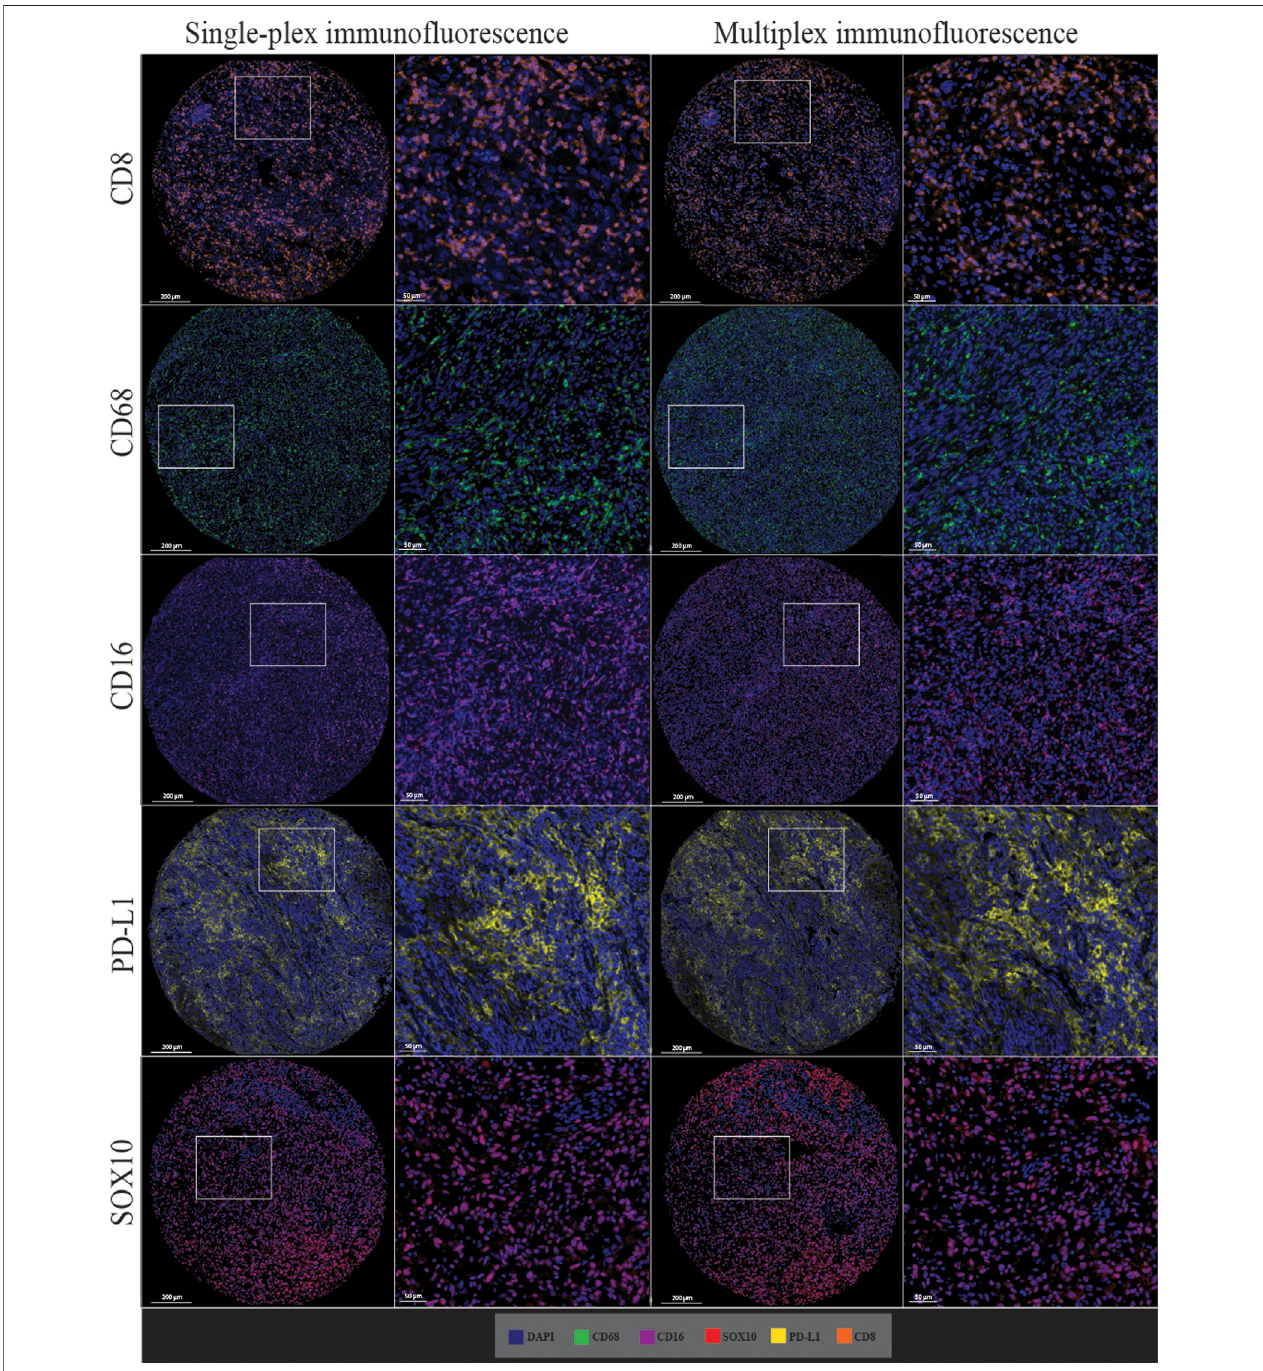
FIGURE 6 | Microphotographs of representative examples of staining in the single-plex immuno fl uorescence (left panels) and the multiplex immuno fl uorescence (right panels) along with corresponding ×20 sample regions from the same patient core for each marker. Antibodies stained with single-plex immuno fl uorescence and multiplex immuno fl uorescence show similar patterns of expression. Scale bars are 200 and 50 µm for the low-magni fi cation (×7.5) and high magni fi cation (×20) microphotographs